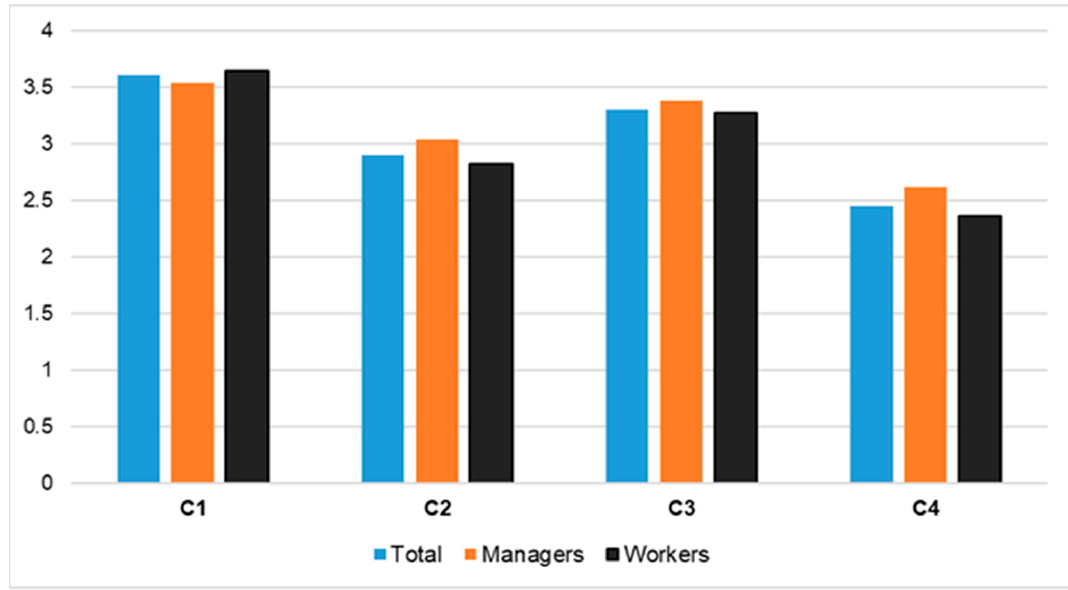
Figure 8. Results of the COVID-19 questionnaire expressed as mean scores (C1, C2, C3, and C4 refer to the responses to the different items of the questionnaire).